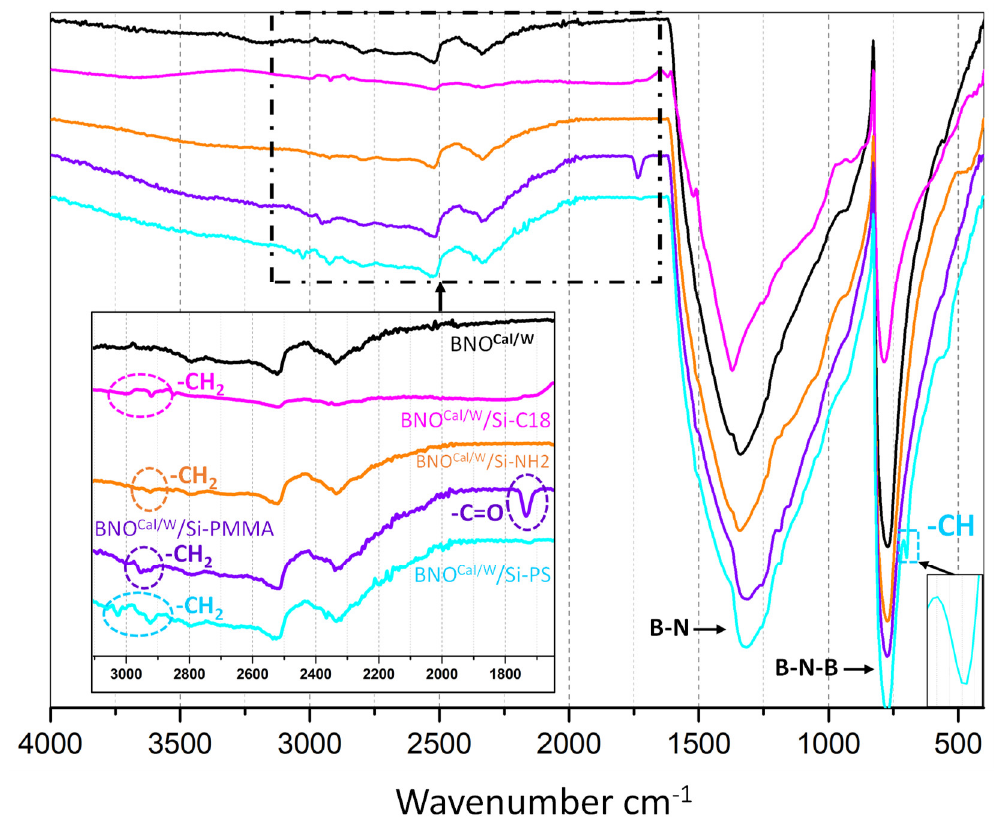
Figure 10. FTIR of BNO Cal/W and grafted BNO Cal/W with several silane grafting agents.